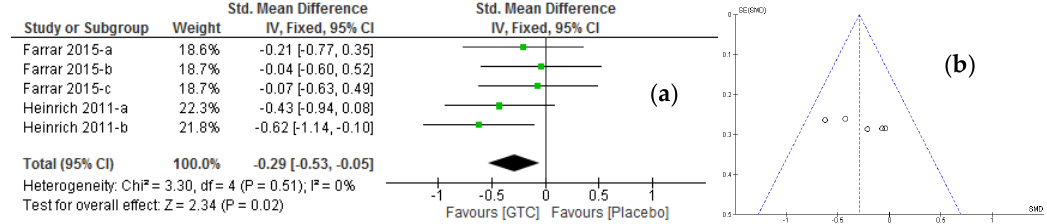
Figure 5. ( a ) Forest plot of randomized controlled studies in healthy adults comparing the effect of oral green tea catechin interventions with placebo showing effectiveness at low intensity (MED challenge ranges between 1.25–1.30) UV-irradiation-induced erythema compared to placebo; ( b ) Funnel plot of representative oral green tea catechins and placebo supplementation studies. Keys : As illustrated in Figure 3.